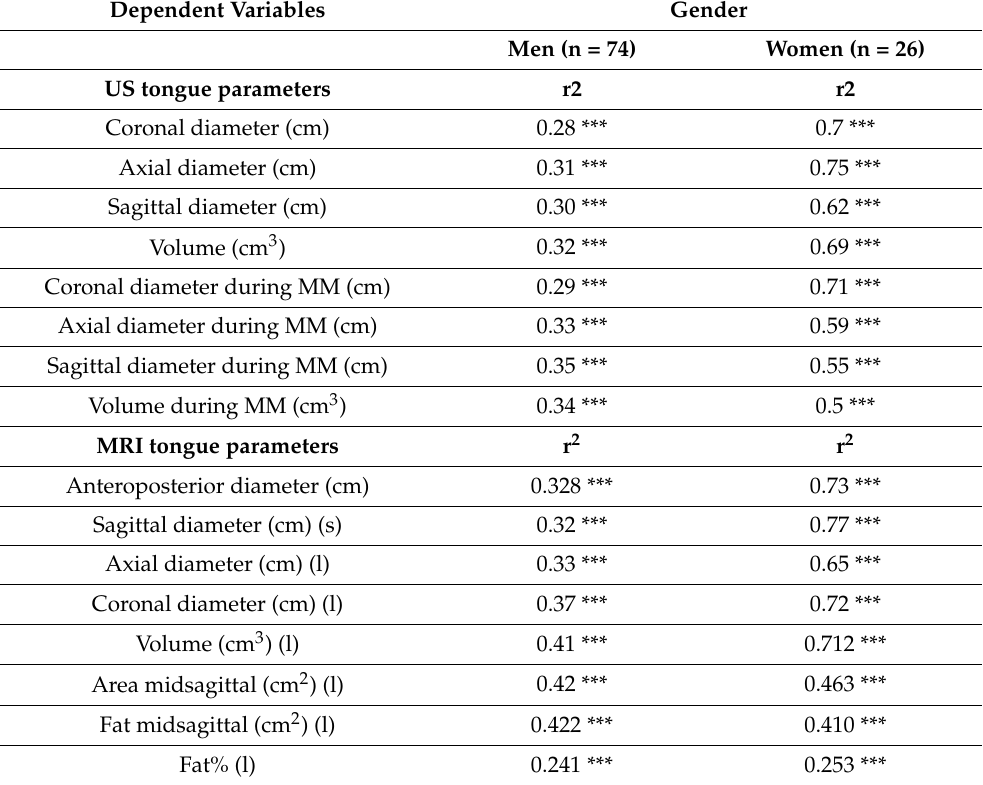
Table 6. Correlation between BMI (as an independent variable) and the US and MRI parameters of the tongue (as dependent variables) in male and female patients. Parameters show the r 2 (determination coefficient) values *** indicates the significant difference at p < 0.01 level, (l) linear estimation and (s) sigmoid estimation. Independent variable: BMI, dependent: tongue parameters.